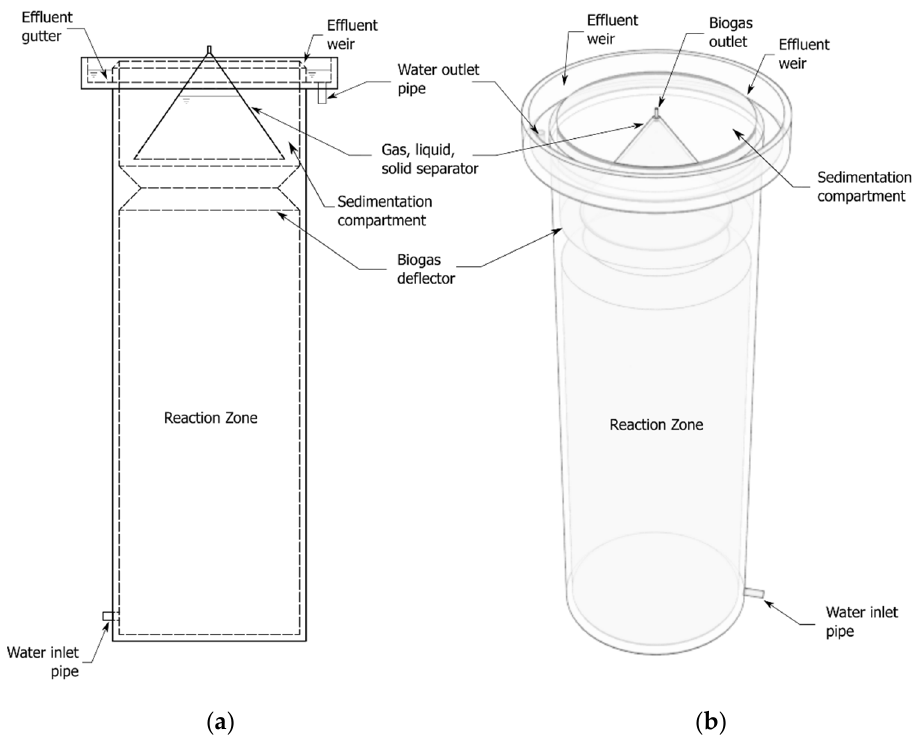
Figure 1. Components of the UASB reactor with IDS configuration C1. ( a ) Cross-section view; ( b ) 3D view. The global reactor’s Reynolds number ( Re ) is calculated using Equation (1), where ρ (cid:0) (cid:1) (cid:0) (cid:1) and µ are the density 998.8 kg/m 3 and dynamic viscosity of the fluid 1.08 × 10 − 3 kg/m s , Q is the flow rate of the reactor, and D is the diameter of the reactor. The resulting Re is close to 450, which indicates that the overall regime of the reactor is